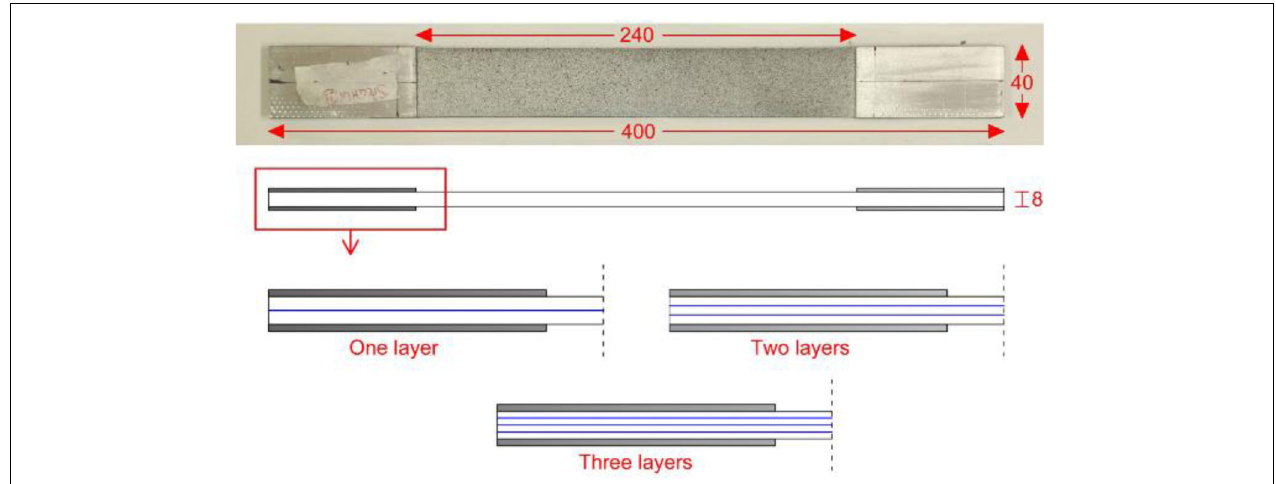
FIGURE 3 | Geometrical features of the specimens tested by D’Anna et al. (2019).